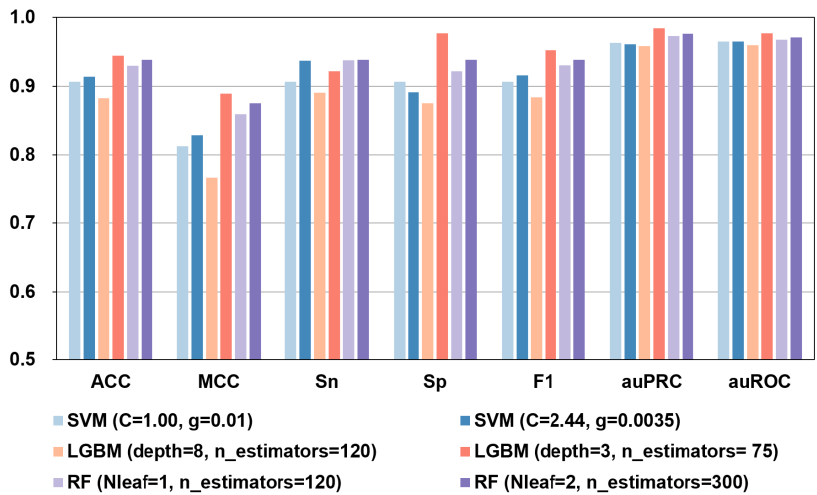
Figure 4. Performance metrics of the UniRep + BiLSTM features analyzed by different models using default parameters (light bars) or hyperparameters (dark bars). Results using selected hyperparameters invariably matched or outperformed default ones.